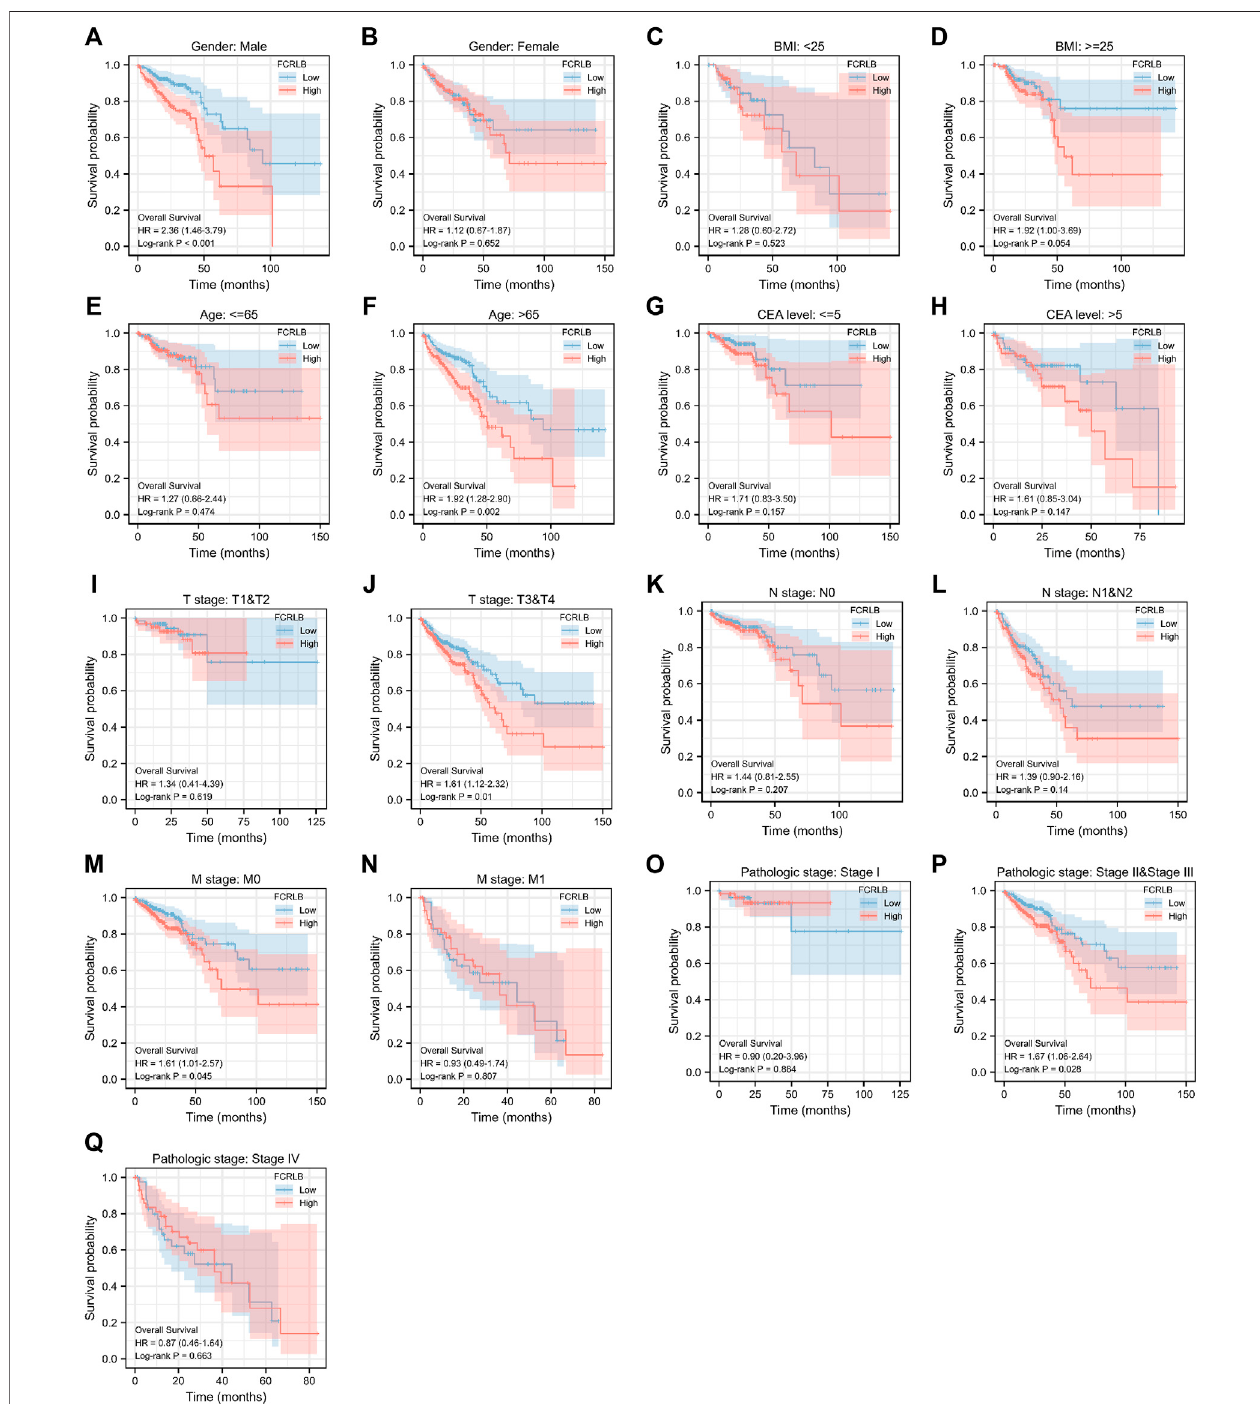
FIGURE 5 | Kaplan-Meier OS curves for FCRLB expression in different clinical subgroups. (A-S) Kaplan-Meier OS curves for FCRLB expression in male subgroup (A) , female subgroup (B) , BMI < 25 subgroup (C) , BMI < 25 subgroup (D) , age ≤ 65 subgroup (E) , age < 65 subgroup (F) , CEA level ≤ 5 subgroup (G) , CEA level ≤ > 5 subgroup (H) , T1 and T2stage subgroup (I) , T3 and T4 stage subgroup (J) , N0 stage subgroup (K) , N1 and N2stage subgroup (L) , M0 stage subgroup (M) , M1 stage subgroup (N) , AJCC pathologic stage I subgroup (O) , AJCC pathologic stage II and III subgroup (P) , AJCC pathologic stage IV subgroup (Q) .